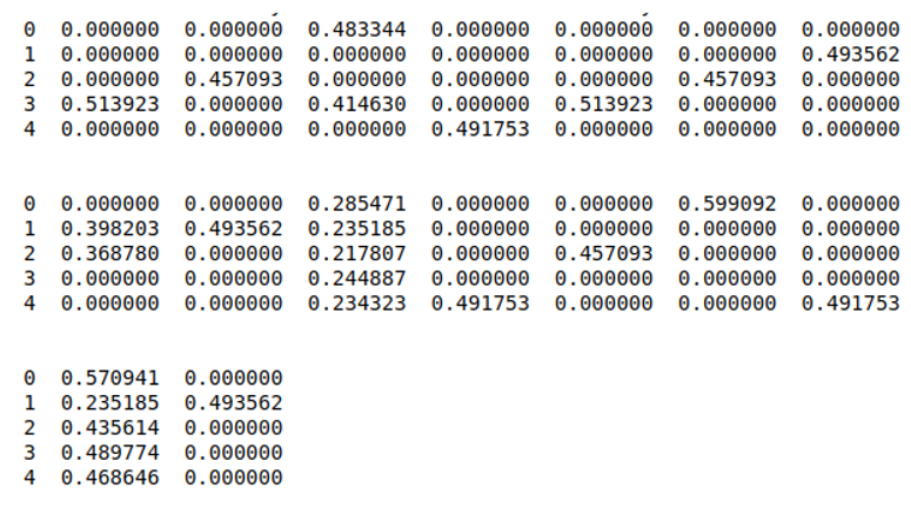
Figure 4. Features’ extracted